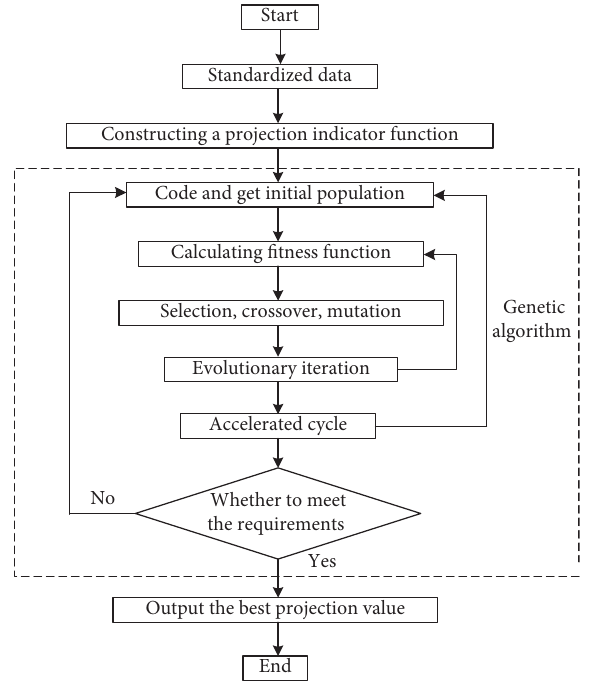
Figure 1: RAGA-PP model